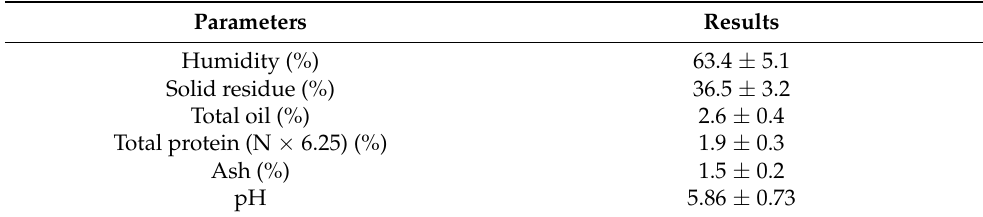
Table 2. Physicochemical characteristics of the fresh two-phase olive pomace (TPOP).